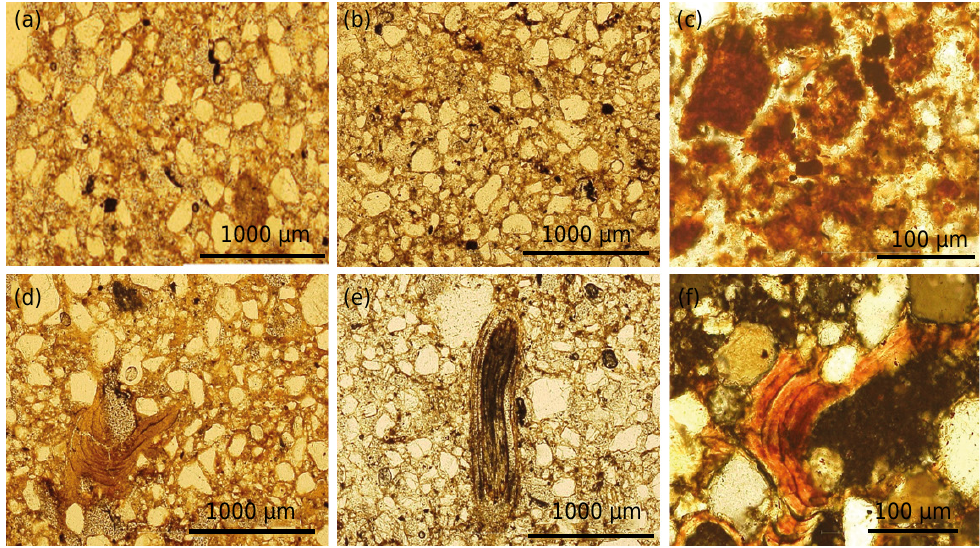
Figure 6. Microphotograph of sediment layers, A horizons and B horizons: (a) gefuric-enaulic relative distribution and granular microaggregates of moderately to strongly developed pedality in A horizons; (b) gefuric-chitonic relative distribution found in the sediments; (c) granular microaggregates found in sediments; (d) occurrence of fine material in loamy sand sediments; (e) biological activity: decomposing roots found in the Ab horizon; (f) dense and massive microstructure of the Btb horizons and dense incomplete clay